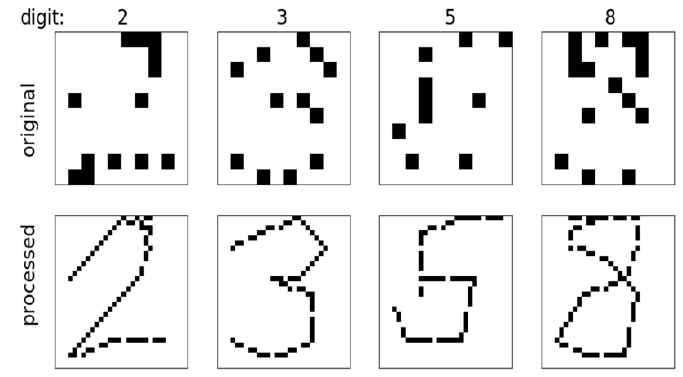
Figure 5. Samples from the dataset. ( top ) raw data; ( bottom ) interpolated data.